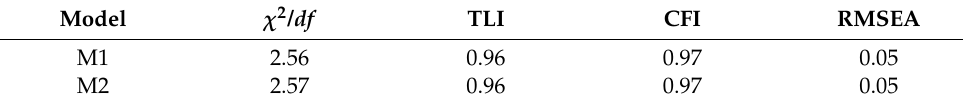
Table 3. Fit indices for the two groups.